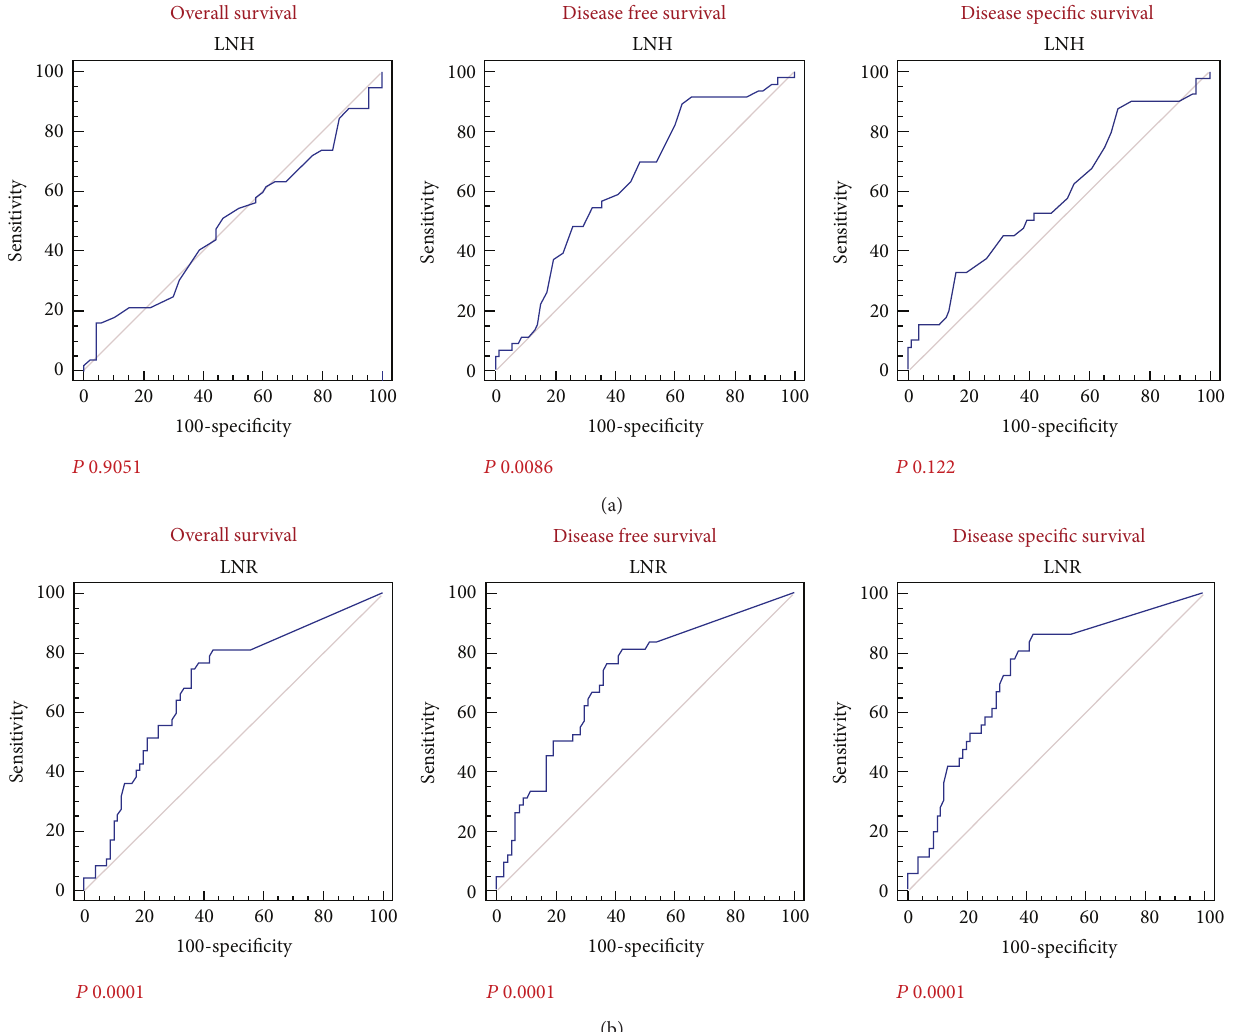
Figure4:GastriccancerandROCcurveanalysis.(a)Overallsurvival,diseasefreesurvival,anddiseasespecificsurvivalROCcurvesaccording to the LNH parameter; (b) overall survival, disease free survival, and disease specific survival ROC curves according to the LNR